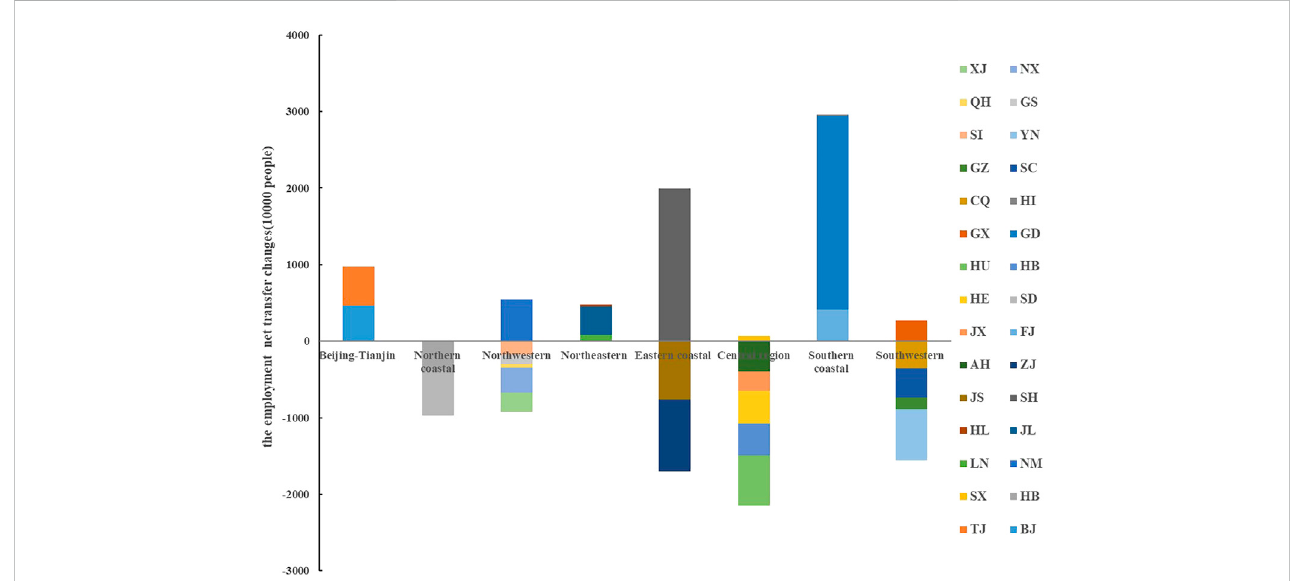
FIGURE 5 Embodied employment net transfer in inter-provincial trade from 2012 to